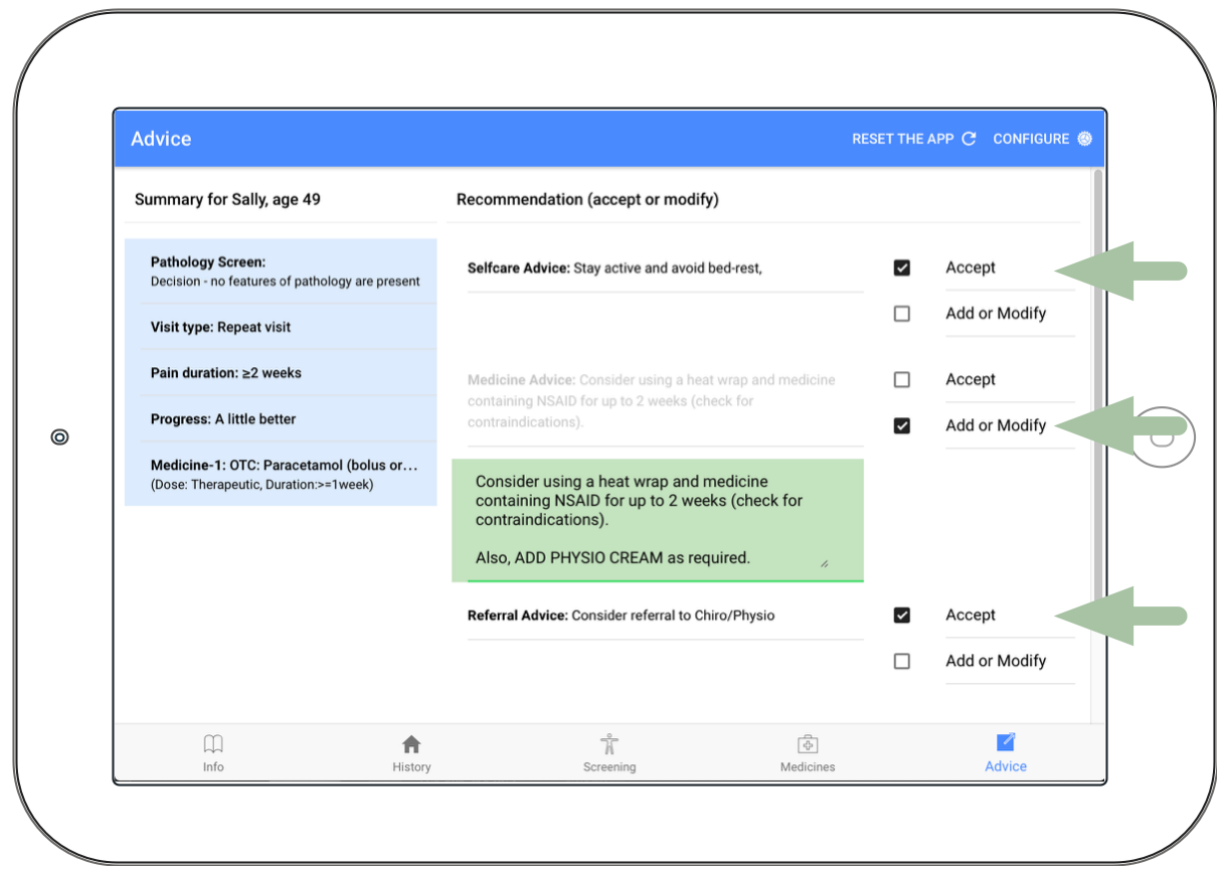
Figure 4. Advice page showing the pharmacist #1 acceptance of self-care advice, the augmentation of medicine advice by the pharmacist (“Also, ADD PHYSIO CREAM as required”), and the acceptance of referral advice (green arrows and green text